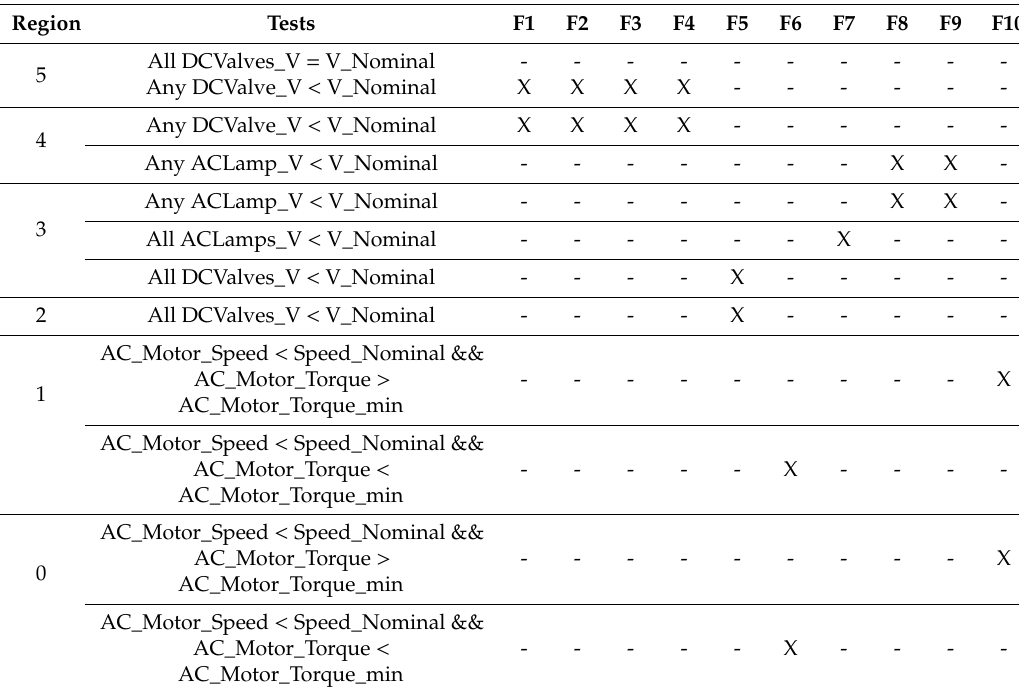
Table 3. Diagnostic matrix for faults vs.